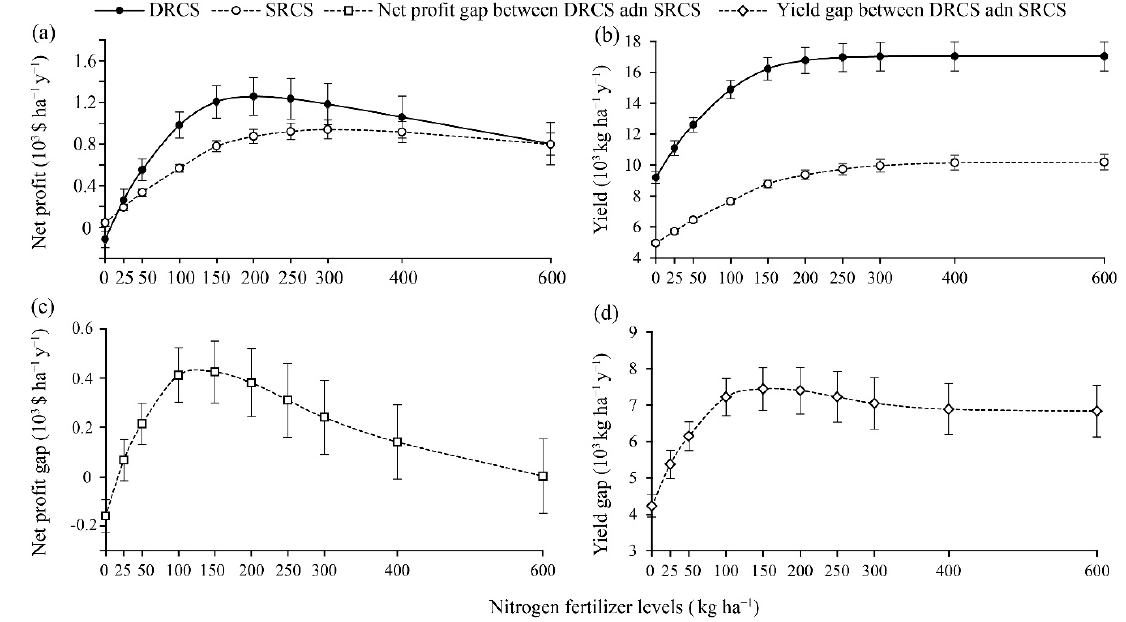
Figure 4. Net profit ($ ha − 1 y − 1 ) ( a ) and rice grain yield (kg ha − 1 y − 1 ) ( b ) for DRCS and SRCS at different nitrogen fertilizer levels during the growing season (kg ha − 1 ) from 1981 to 2015. Note: Error bars indicate the standard deviations. ( c ) Net profit gap between DRCS and SRCS. ( d ) Rice grain yield gap between DRCS and SRCS.